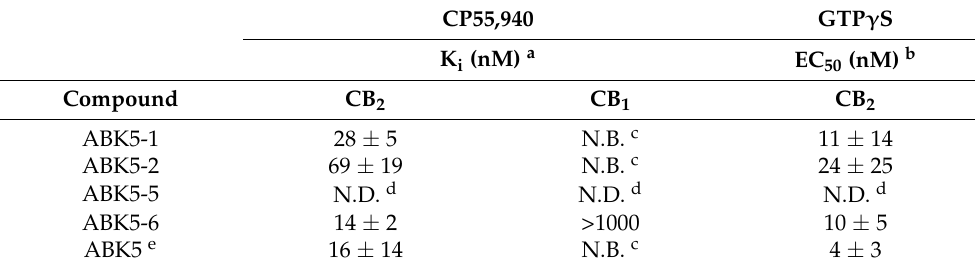
Figure 3. Specific [ 35 S]GTP γ S binding to CB 2 induced by ABK5-1, ABK5-2, and ABK5-6. Concentra- tions of ABK5-1 (circles), ABK5-2 (squares), ABK5-6 (triangles) that caused stimulation of the specific binding of [ 35 S]GTP γ S to CB 2 . Data are depicted as the mean ± S.D. of three independent experiments with each experiment carried out in duplicate. Table 1. Binding and G-protein-stimulation properties of ABK5 derivatives.